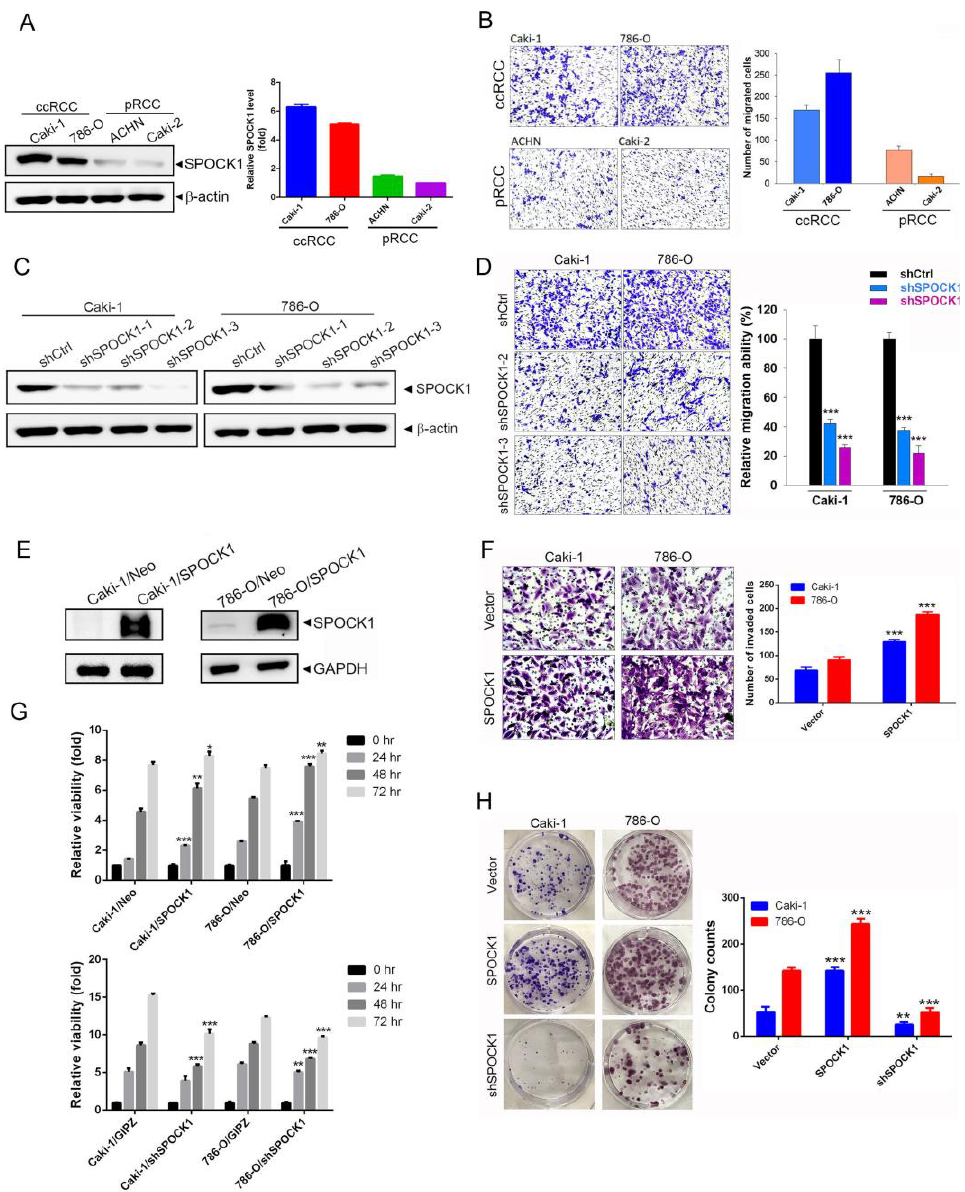
Figure 2. SPOCK1 overexpression promotes the proliferation, clonogenicity, migration, and invasion of clear cell renal cell carcinoma (ccRCC) cells. ( A ) Endogenous SPOCK1 protein levels were detected using a Western blot analysis of ccRCC (Caki-1 and 786-O) and papillary (p)RCC (ACHN and Caki-2) cells. ( B ) The migratory ability of ccRCC and pRCC cells was examined by a transwell migration assay. ( C ) Knockdown efficiencies of three SPOCK1 shRNAs were determined by West- ern blotting in Caki-1 and 786-O cells. ( D ) Migratory abilities of SPOCK1-KD Caki- 1 and 786− O cells